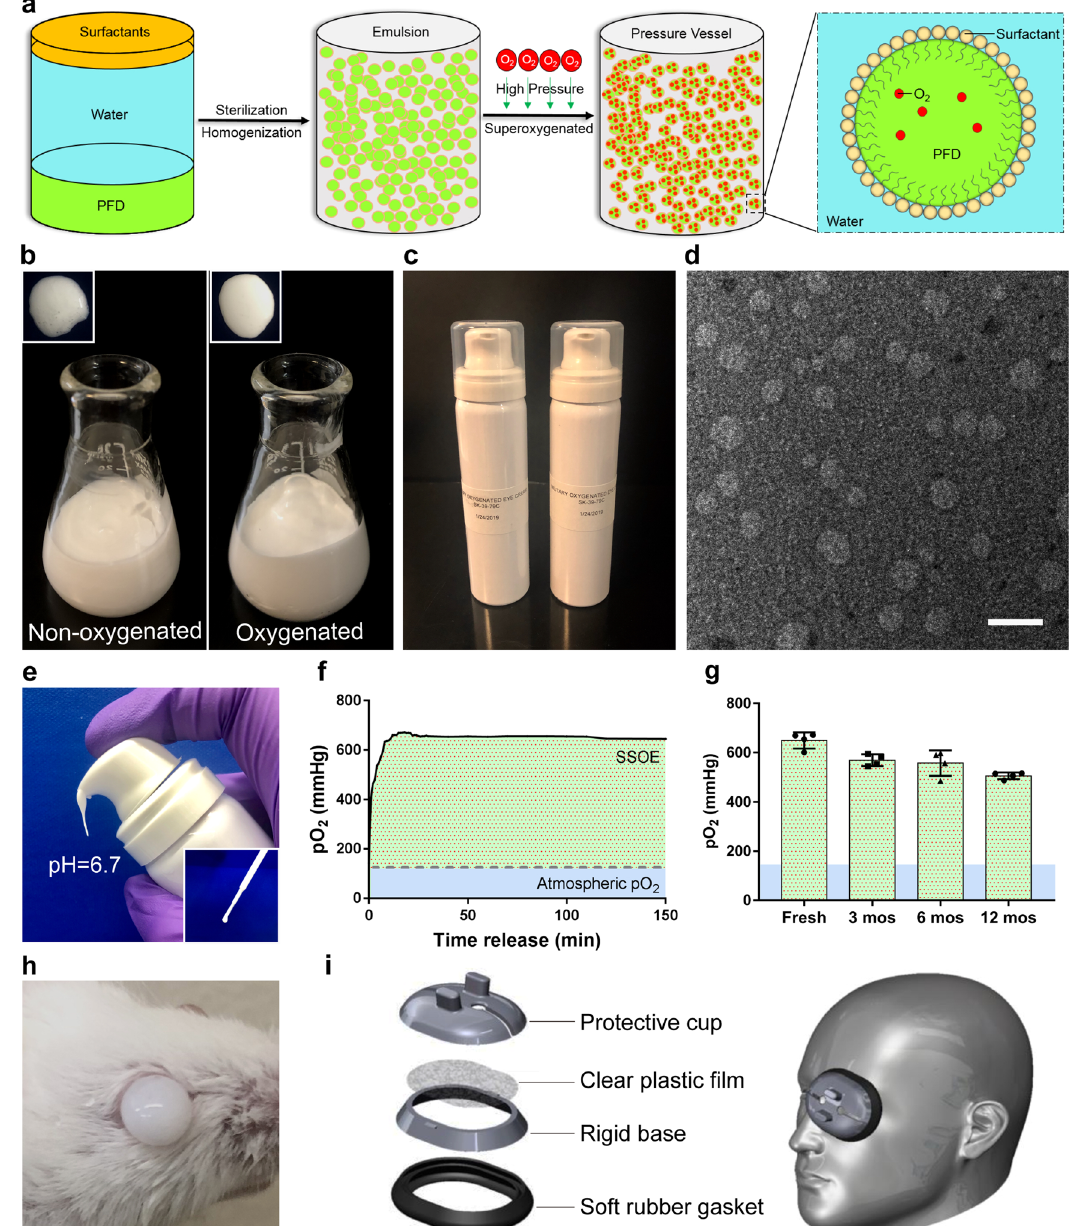
Fig.1|Formulationandcharacterizationofophthalmicsupersaturatedoxygen emulsion (SSOE). a Schematic depicting SSOE manufacture. PFD, surfactants